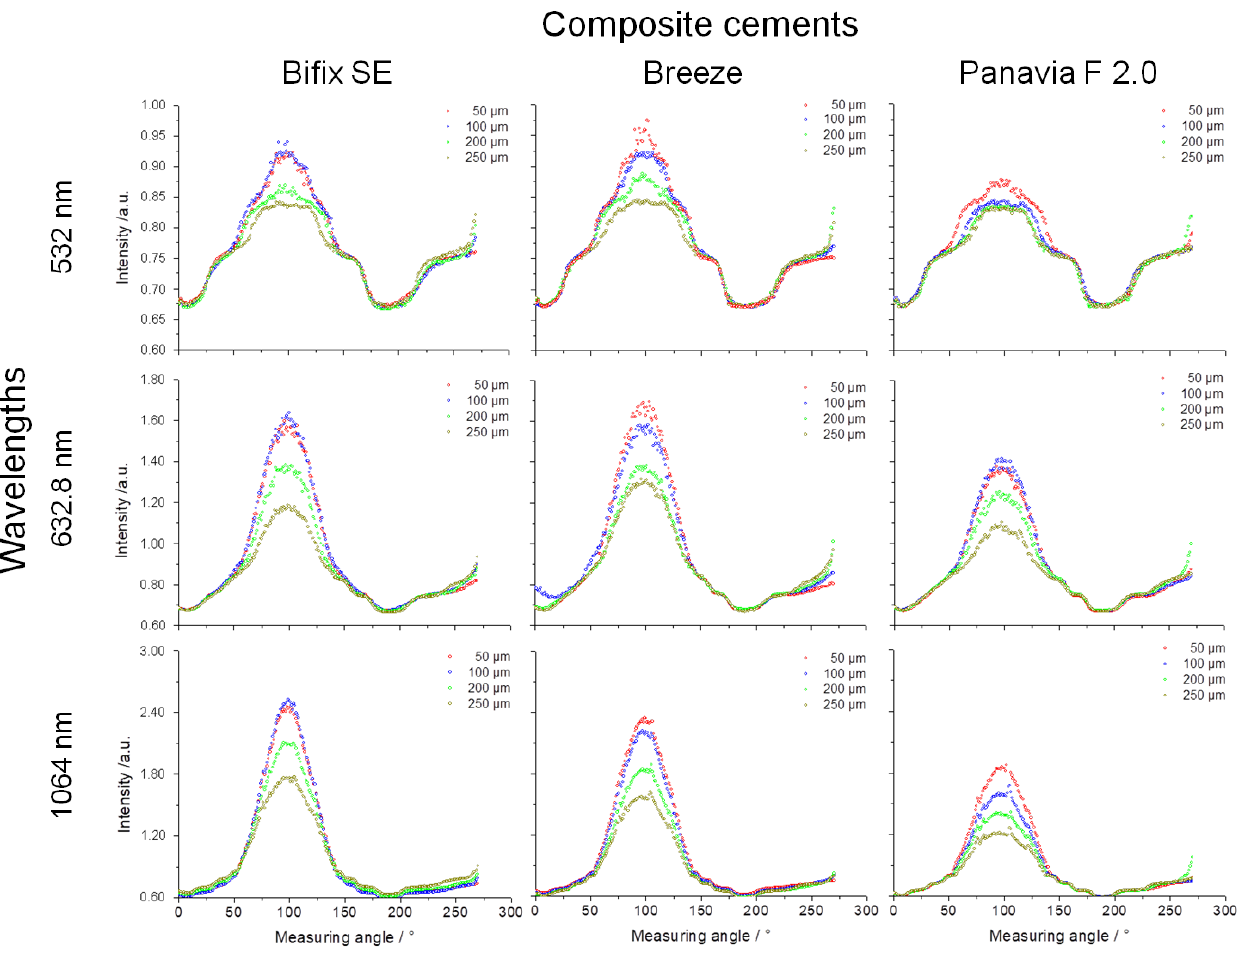
Figure 6. Intensity and line width (FWHM) diagrams, in the x-axis according to Figure 1 from “light” to “dark” cements, and in the y-axis, the wavelength dependency from short-wave (upper) to long-wave radiation (lower). The layer thicknesses are color-coded in the graphs. Table 2. Measured intensities and line widths (FWHM) as a function of material, wavelength, and layer thickness. The reported intensity values are the maximum values at the measuring angle 100 ◦ of the individual curves from Figure 6. The corresponding line widths were determined according to Figure 5.